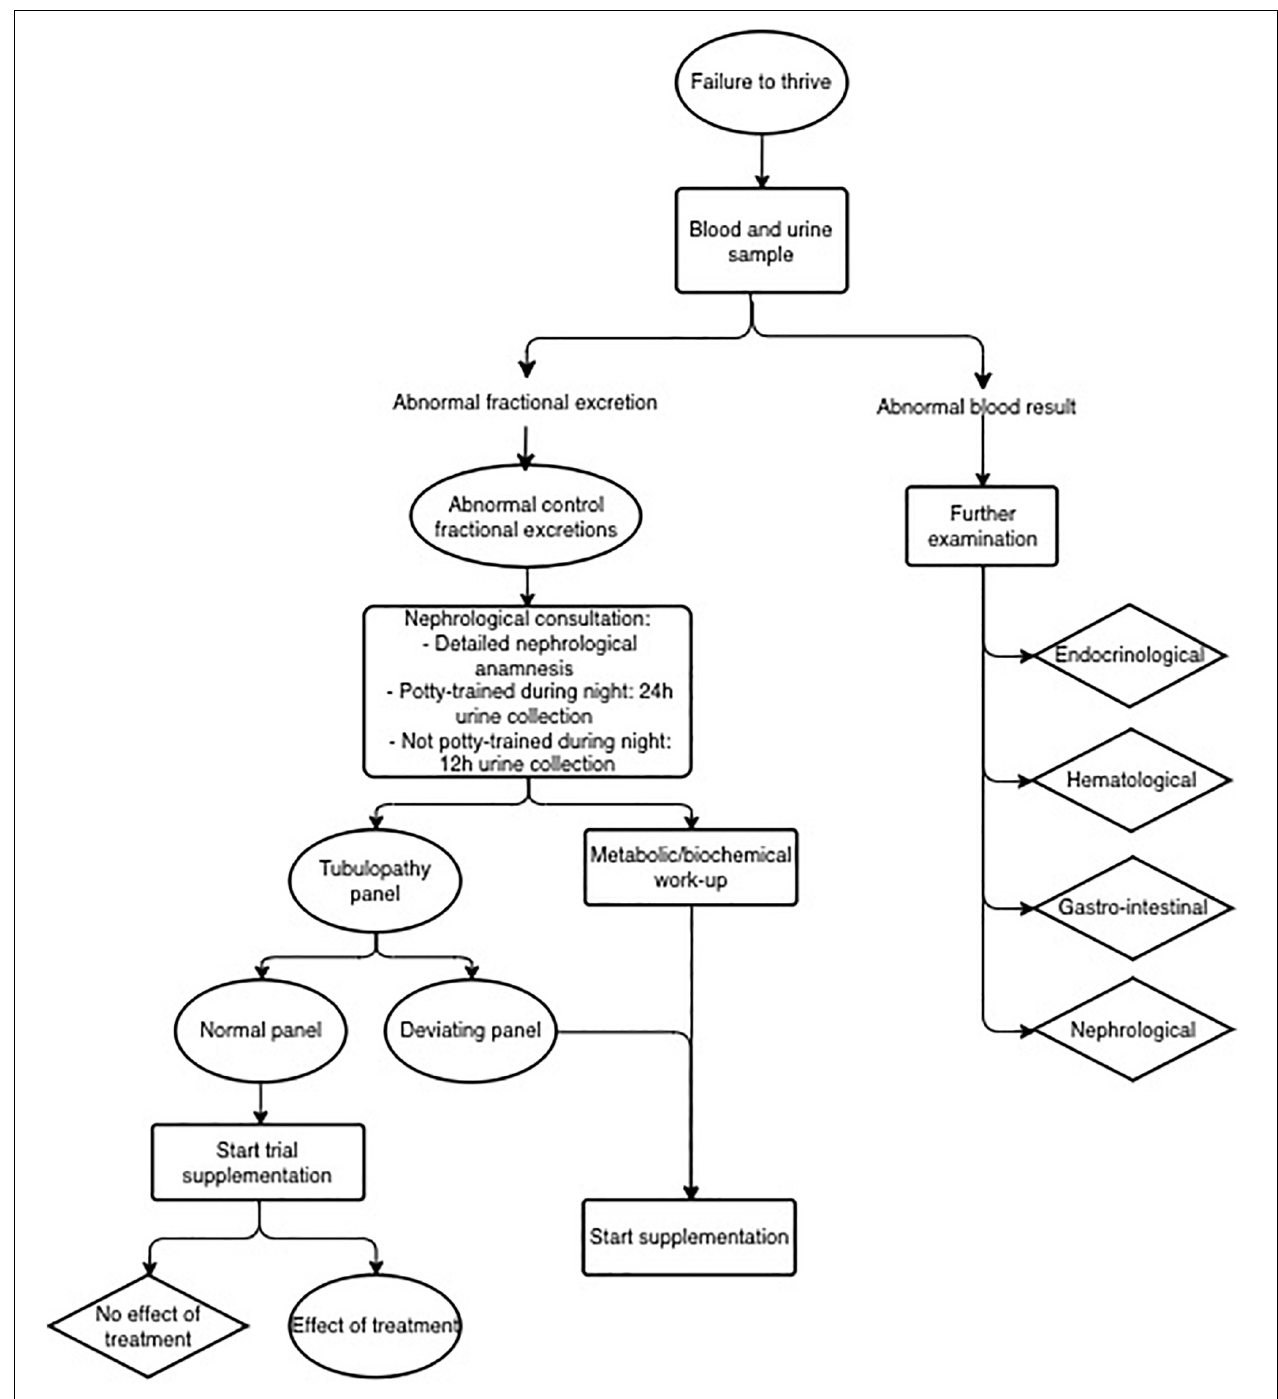
FIGURE 5 | Flow chart for failure to thrive.